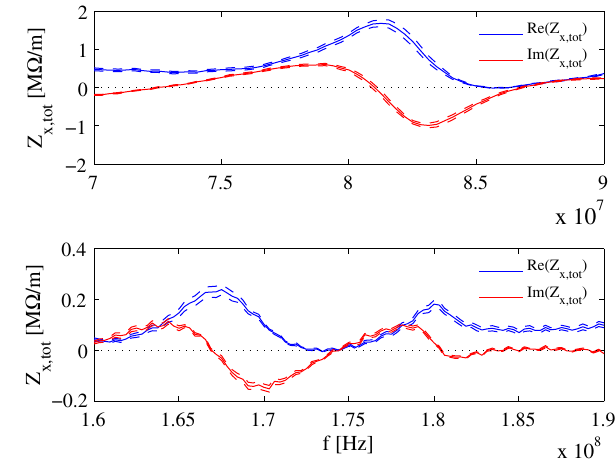
FIG. 15. Transverse impedance calculated at the full gap of 5 mm. The dashed lines refer to the uncertainty of the